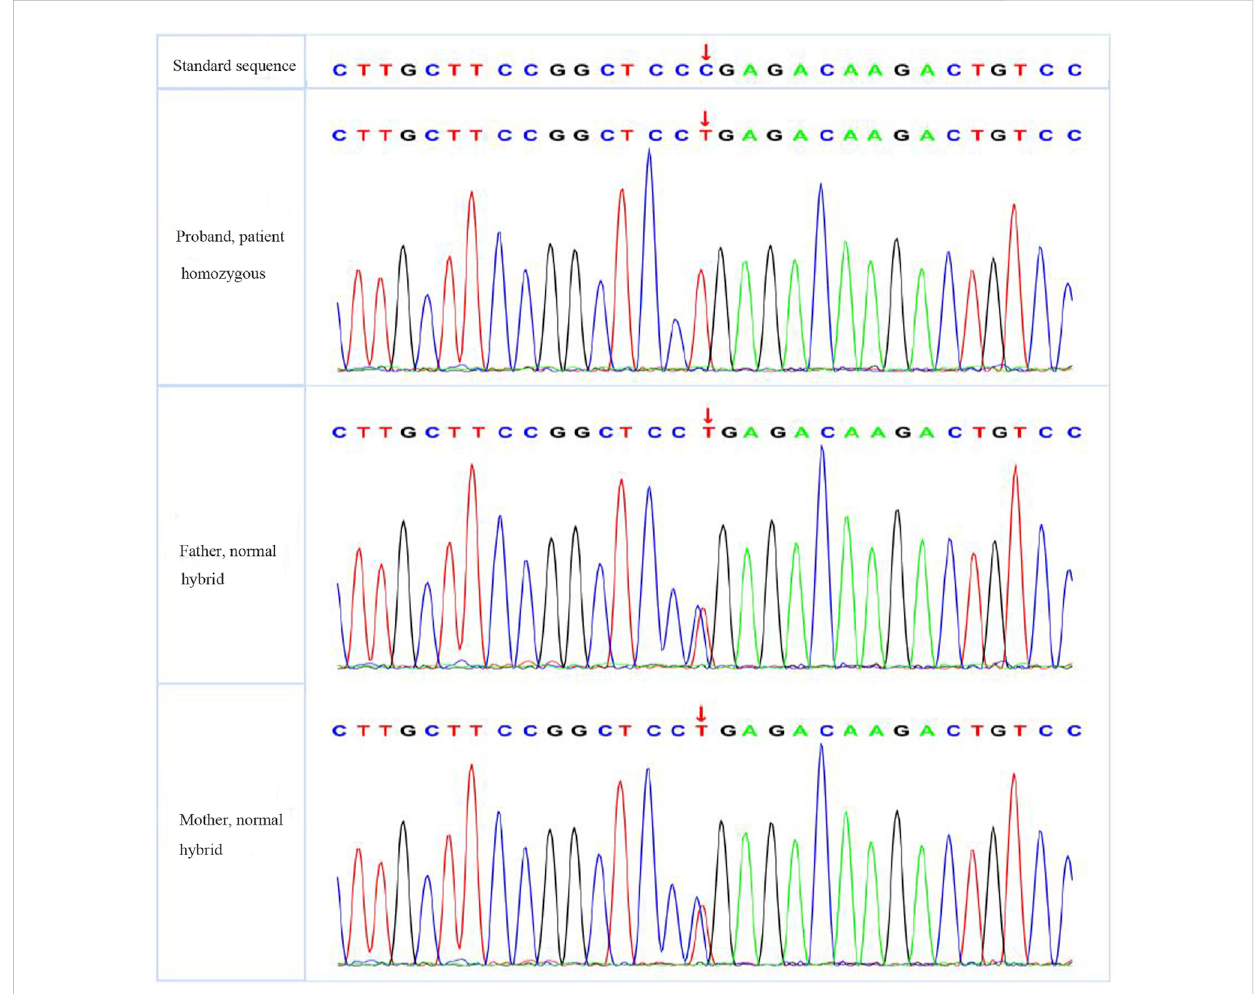
FIGURE 4 Sequencing results of PCR products of the proband and his family